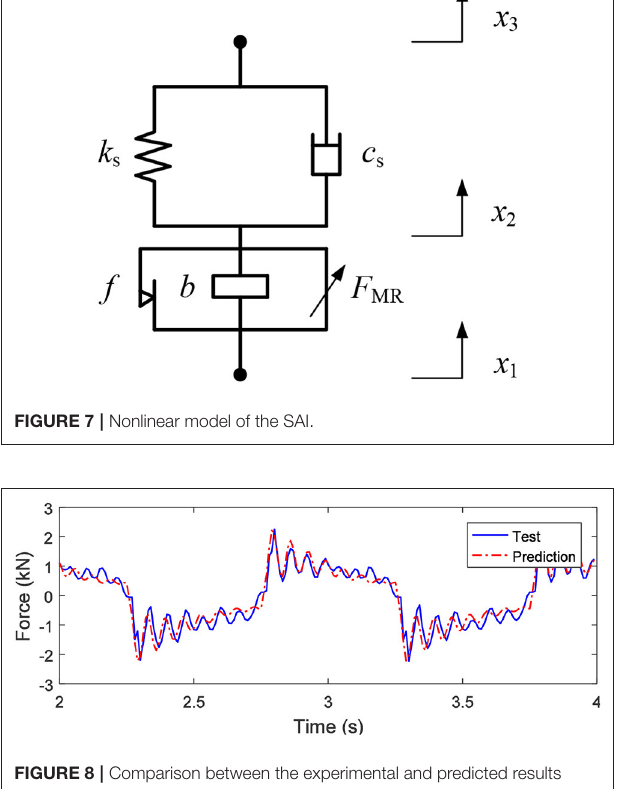
FIGURE 8 | Comparison between the experimental and predicted results when under a sinusoidal displacement excitation with an amplitude of 20mm and a frequency of 1.0Hz and a 0.5A applied